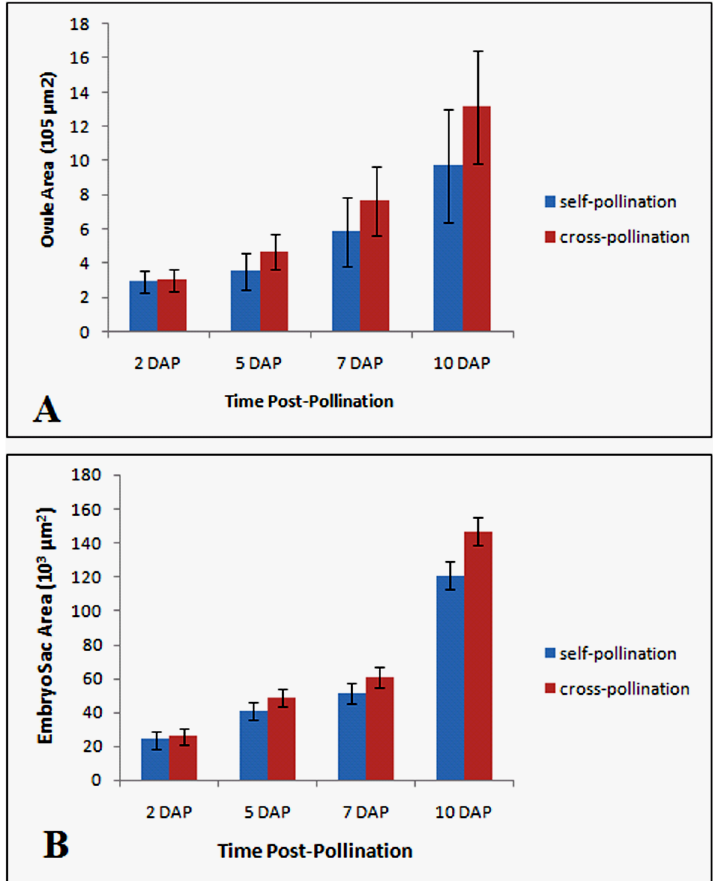
Fig 2. Mean area of the median longitudinal section of ovule and embryo sac after cross- and self- pollination of Xanthoceras sorbifolium . A: Ovule area; B: Embryo sac